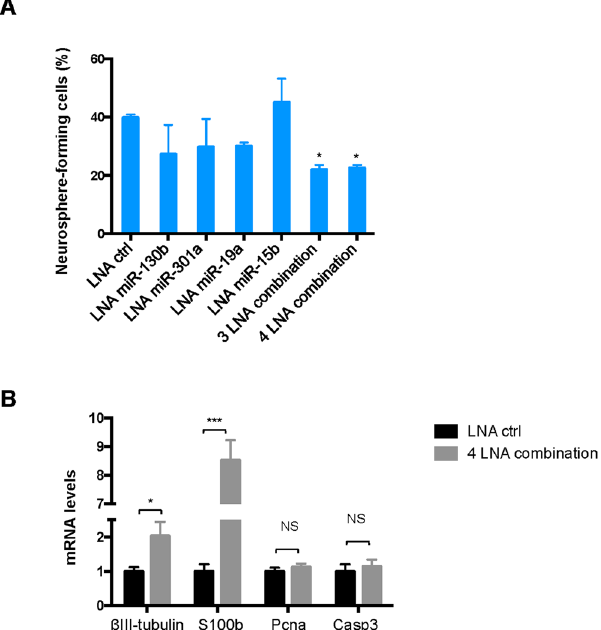
Figure 5. Foxm1-mediated miRNAs and miRNA clusters affect NSC neurosphere formation. ( A ) Neurosphere- formation capacity of NSCs transfected with LNA anti-miR-130b, -miR-301a, miR-19a (to inhibit miR-17- 92 cluster members) and miR-15b (to inhibit miR-15–16 cluster members) that were used separately and combined. [3 LNA combination: anti- miR-130b, -miR-301a, and miR-19a; 4 LNA combination: anti-miR-130b, -miR-301a, miR-19a, and miR-15b]. P values vs. scrambled LNA control (One-way ANOVA test): * P < 0.05: 3 LNA combination: 0.0424; 4 LNA combination: 0.0500). ( B ) RT-qPCR data showing β III-tubulin, S100b, Pcna and Casp3 mRNA levels after 4 LNA combination. P values vs. scrambled LNA control (Two-way ANOVA test): * P < 0.05: 0.047 ( β III-tubulin), *** P < 0.001: 0.00086 (S100b), NS: Not Significant (Pcna, Casp3). Bars in A and B panels represent means (SD) of at least three independent